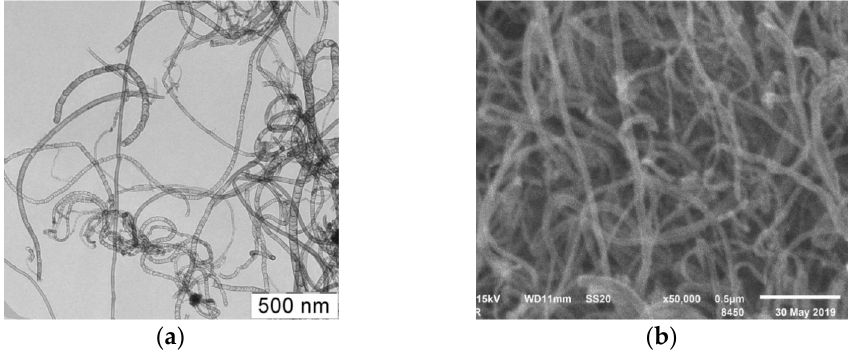
Figure 7. TEM ( a ) and SEM-image ( b ) of N-CNT obtained using a gas mixture of C 3 H 8 -NH 3 (50/50%) at a temperature of 800 ° С .